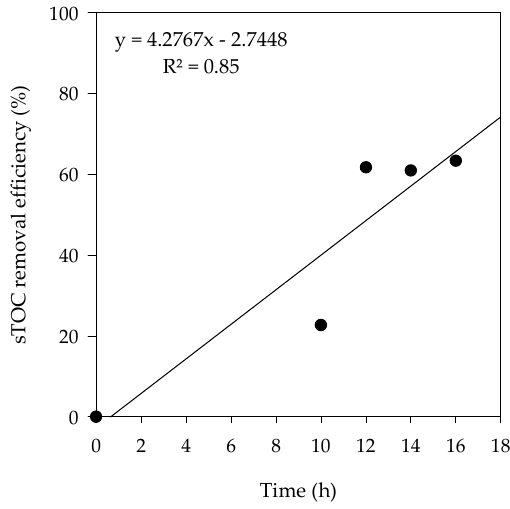
Figure 7. Time lapsed sTOC removal efficiency in electrochemical treatment.